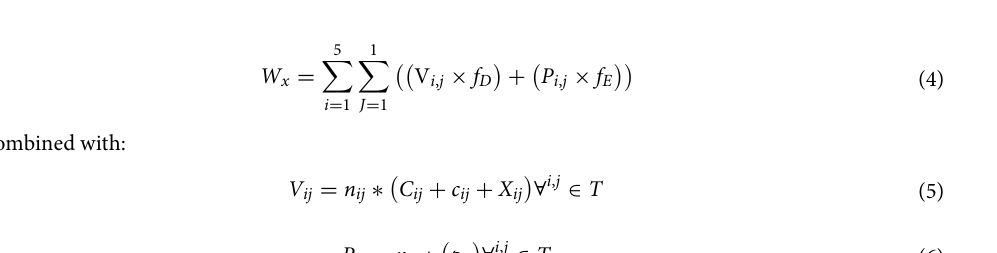
Figure 1. Typical layouts of container